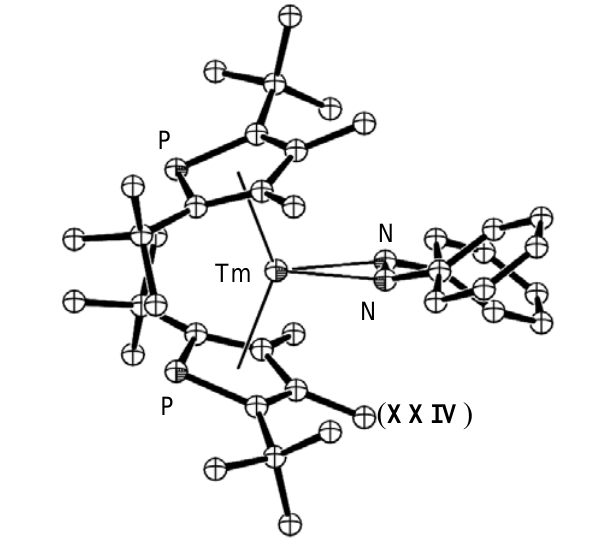
Figure 11. Molecular structure of [(PC Figure generated from CCDC obtained coordinates. Atoms of arbitrary size. H atoms are omitted for